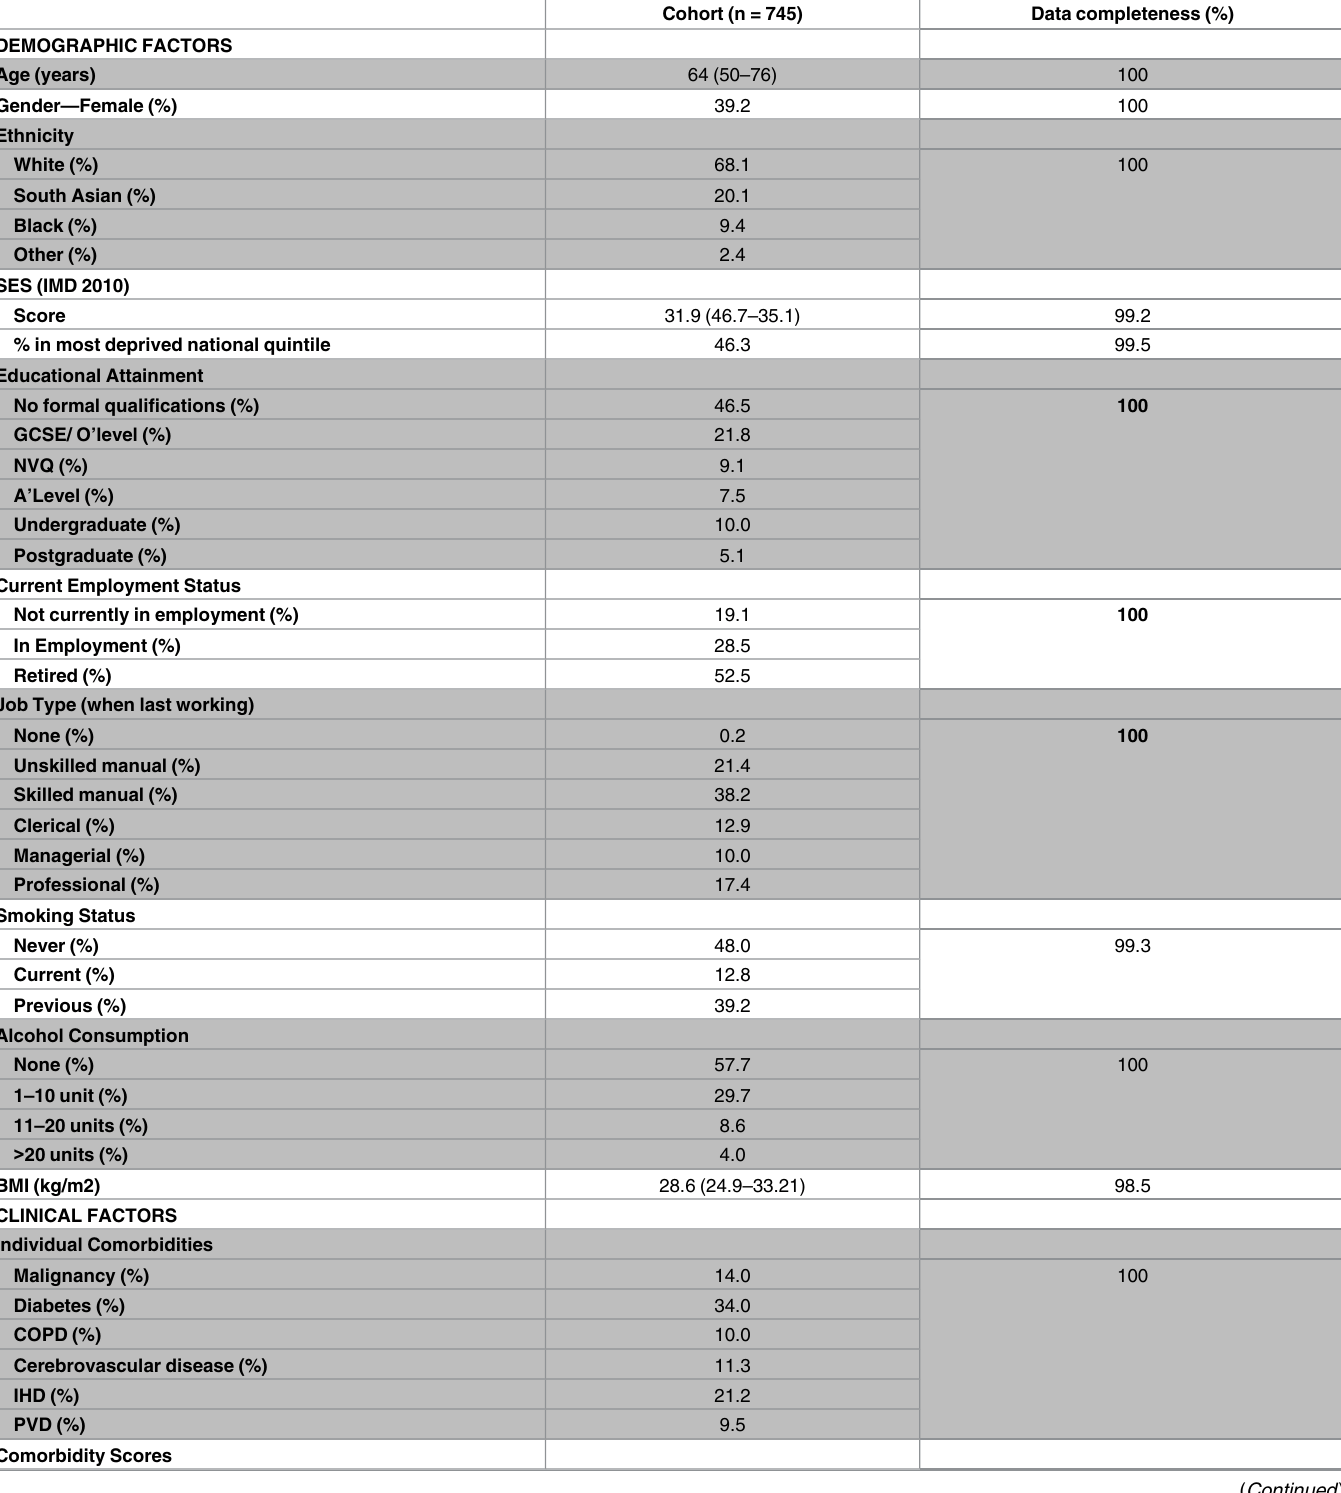
Table 1. Demographic, clinical and laboratory data. Categorical variablesare expressedas number (%), and continuous variables as mean (SD) or median(IQR).